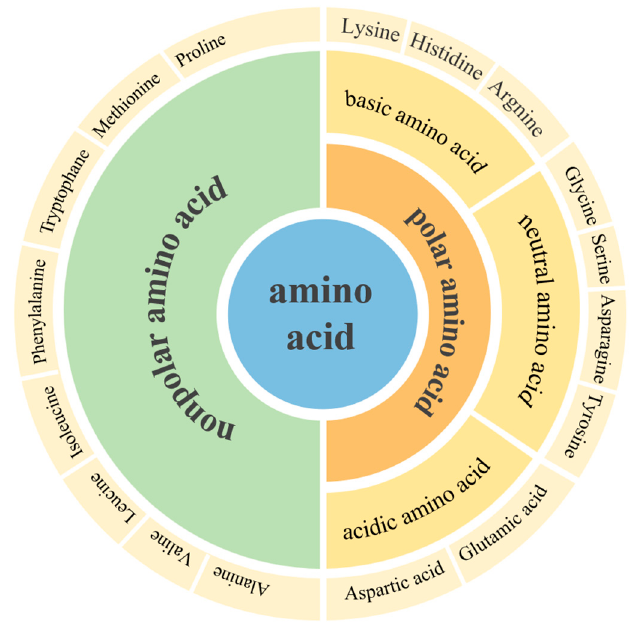
Figure 6. Amino acids and classification.